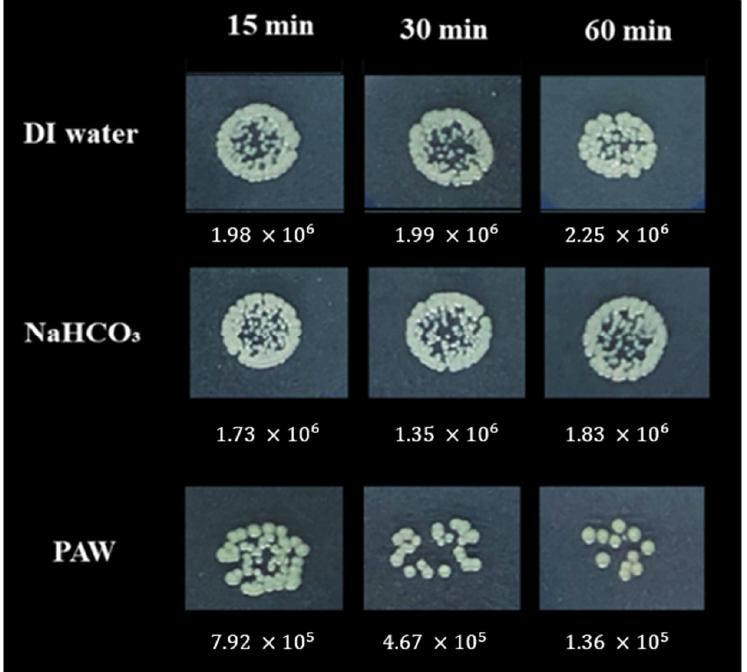
Figure 6. The inactivation of E. coli in the suspension after being treated by DI water, NaHCO 3 , and PAW after treatment time for 15, 30, and 60 min.